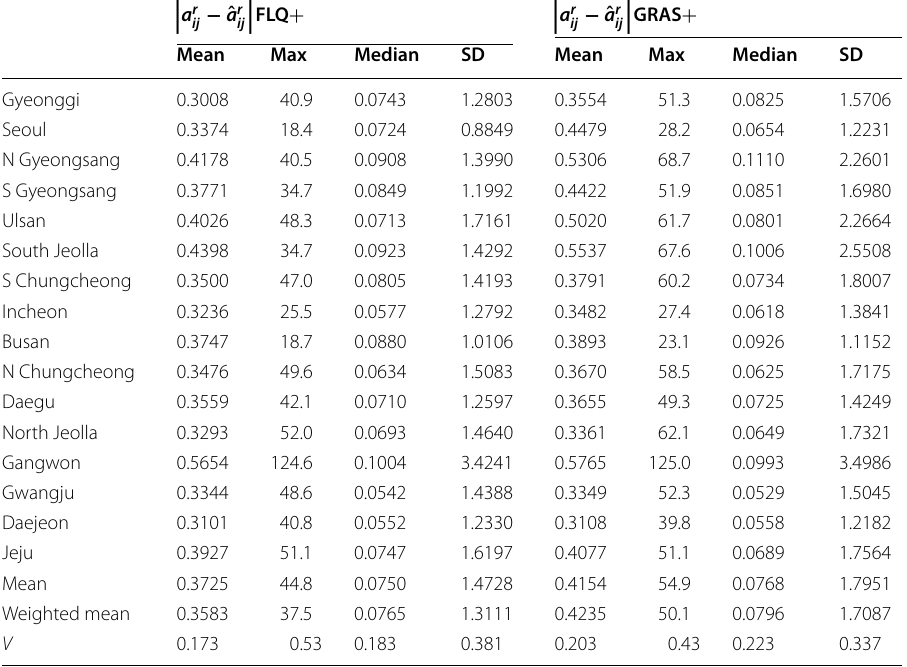
100) between the observed and estimated ‘inverse × and GRAS + +